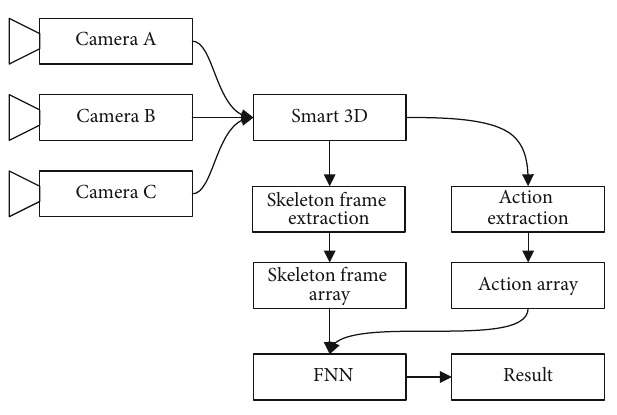
Figure 1: Overall algorithm